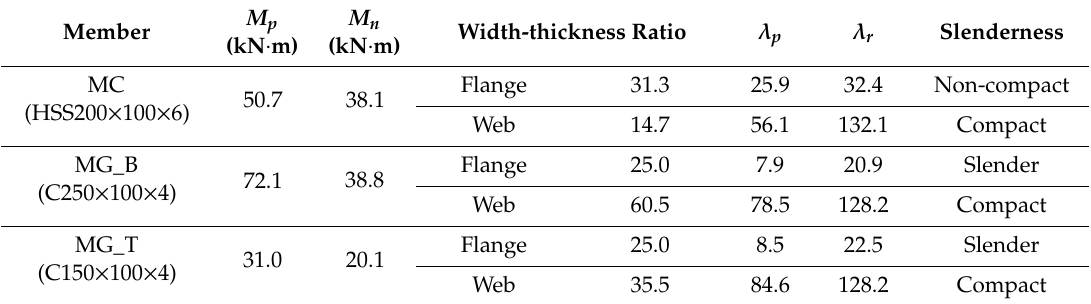
Table 5. Plastic and nominal moment capacity of the beam and column members of the test specimen.